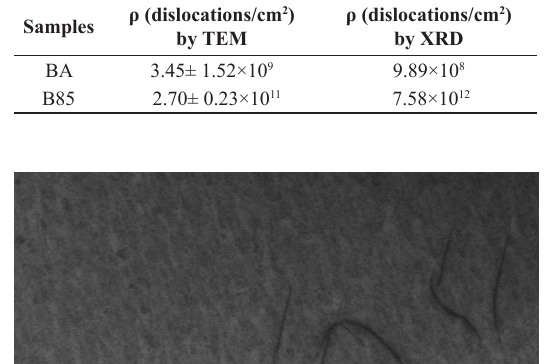
Table 1. Dislocation density (ρ) obtained through TEM and XRD methods for annealed and cold rolled samples.